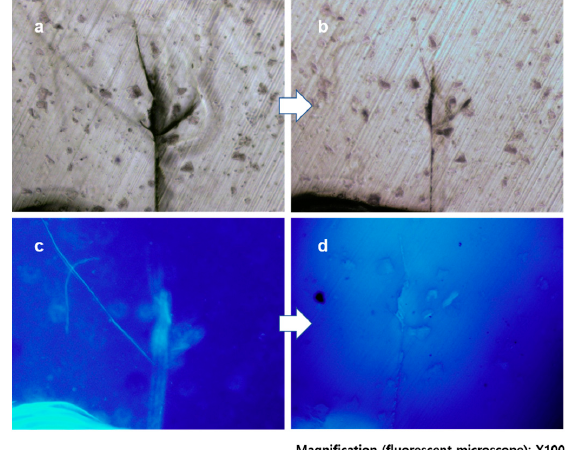
Figure 4. Crack-healing of TCE-co-DCE. ( a , b ) Optical images of cracked epoxy embedding self-healing microcapsules (a) and the same area after irradiation of light (b). ( c , d ) Fluorescence images of cracked epoxy (c) and the same area after irradiation of light (d).